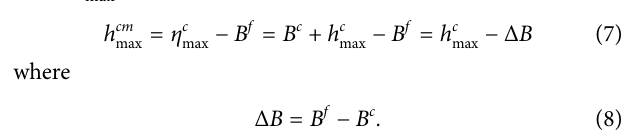
Frontiers in Earth Science |